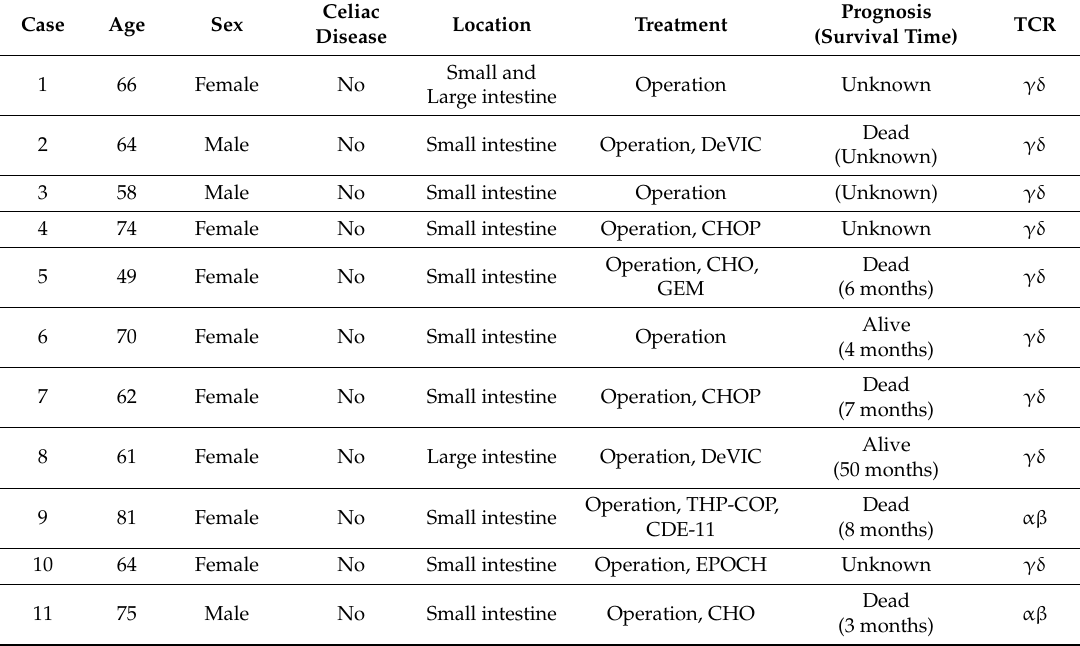
Table 1. Clinical features of the patients and T-cell receptor (TCR)